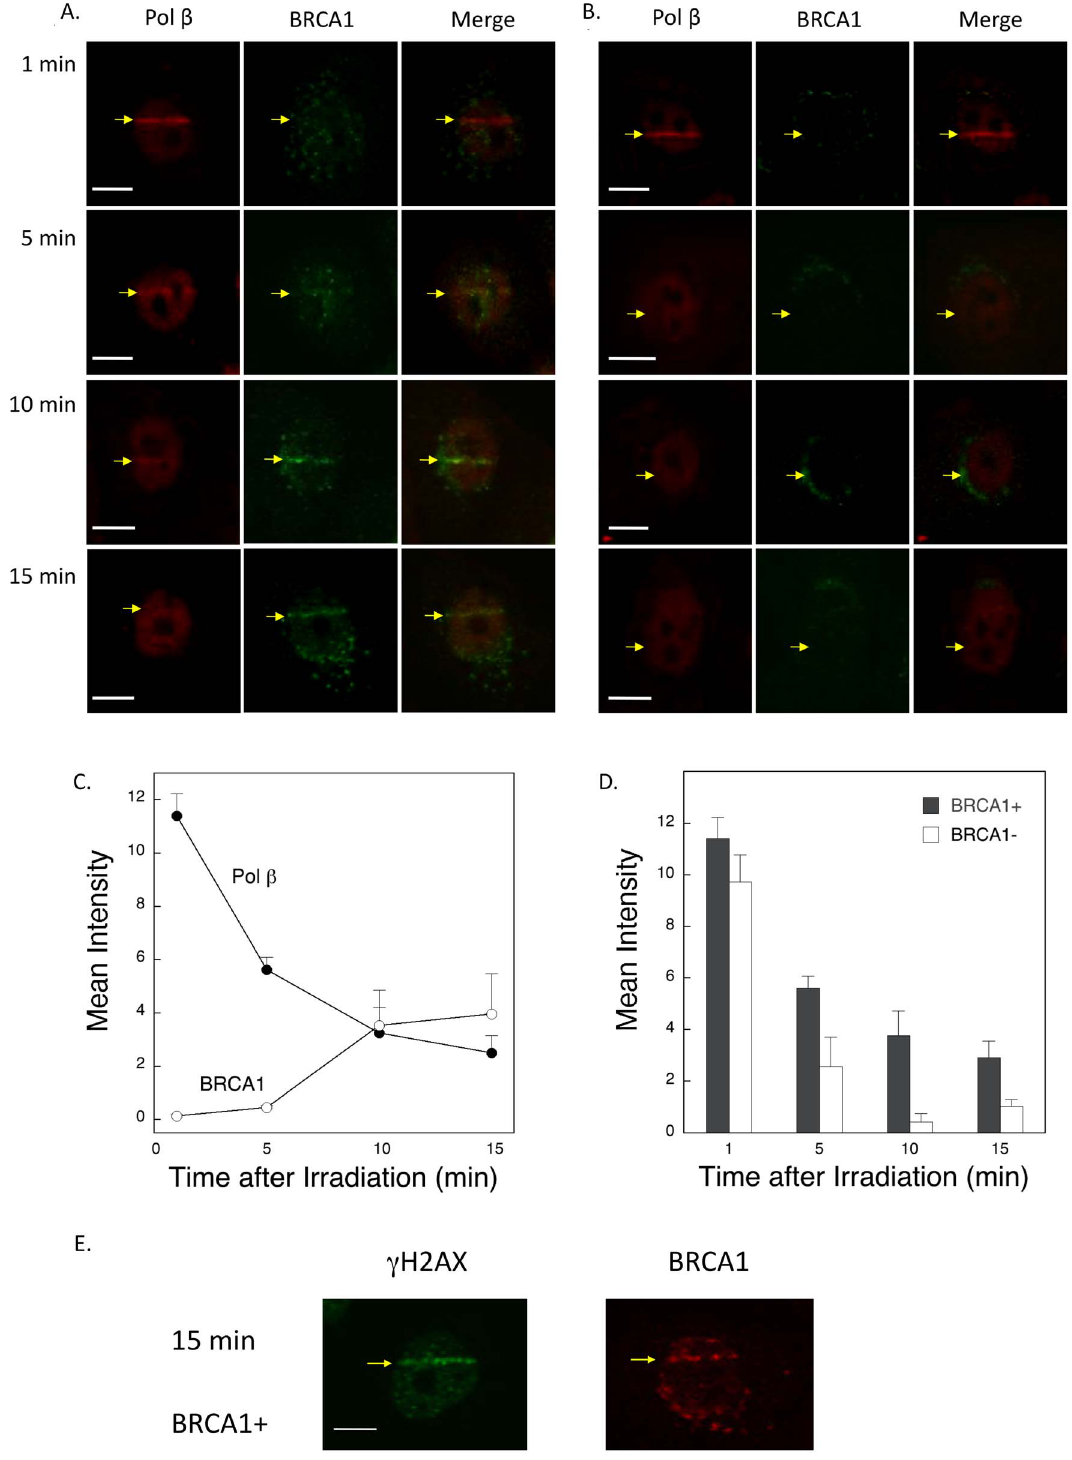
Figure 5. Immunofluorescence imaging of pol b and BRCA1 in human cells using anti-pol b and anti-BRCA1 antibodies. Experiments were conducted as described under ‘‘Materials and Methods,’’ and typical results are shown. A. BRCA1 positive and B. BRCA1 negative cells were irradiated in stripes and then allowed to repair for the indicated times before assessment for pol b and BRCA1 recruitment, as indicated. C. Summary of intensities of the pol b and BRCA1 signals as a function of time after irradiation of the BRCA1-expressing cells. Quantification was of at least 18 cells for each protein with error bars representing mean 6 SD. D. Summary of intensities of the pol b signals, as a function of time after irradiation, in the BRCA1 positive cells ( + , solid bars) and negative cells ( 2 , open bars). Values plotted represent mean 6 SD corresponding to 4 cells at each point. E. Imaging of c -H2AX in the BRCA1-expressing ( + ) cells 15 min after irradiation. Bars represent 10 m m.